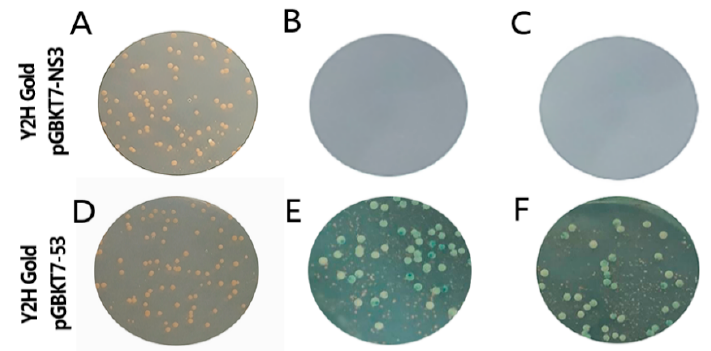
Figure 2. Autoactivation and toxicity verification of NS3 bait protein: ( A – C ) Y2H yeast transformed with bait pGBKT7-NS3 grow on SDO, SDO/X, and SDO/X/A culture media and ( D – F ) Y2H yeast transformed with pGBKT7-53 positive control grow on DDO, DDO/X, and DDO/X/A culture media.